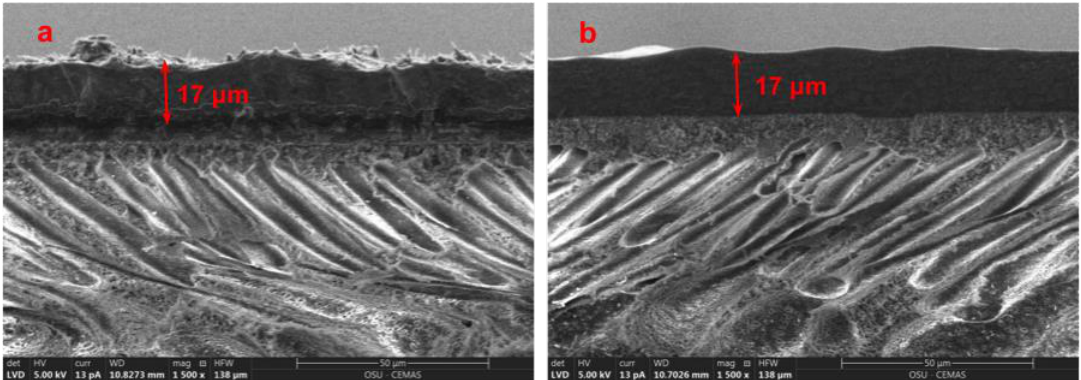
Figure 12. Cross-sectional SEM images of membrane with 10 wt.% AF-MWNTs ( a ) before and ( b ) after the 100-h stability test at 1.5 MPa.